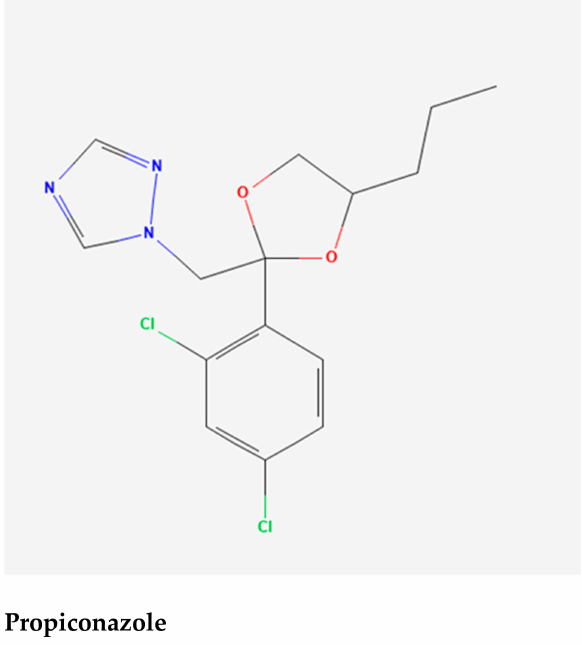
Figure 4. Selected phytochemicals (ligands) of the extracts of Gynura nepalensis .